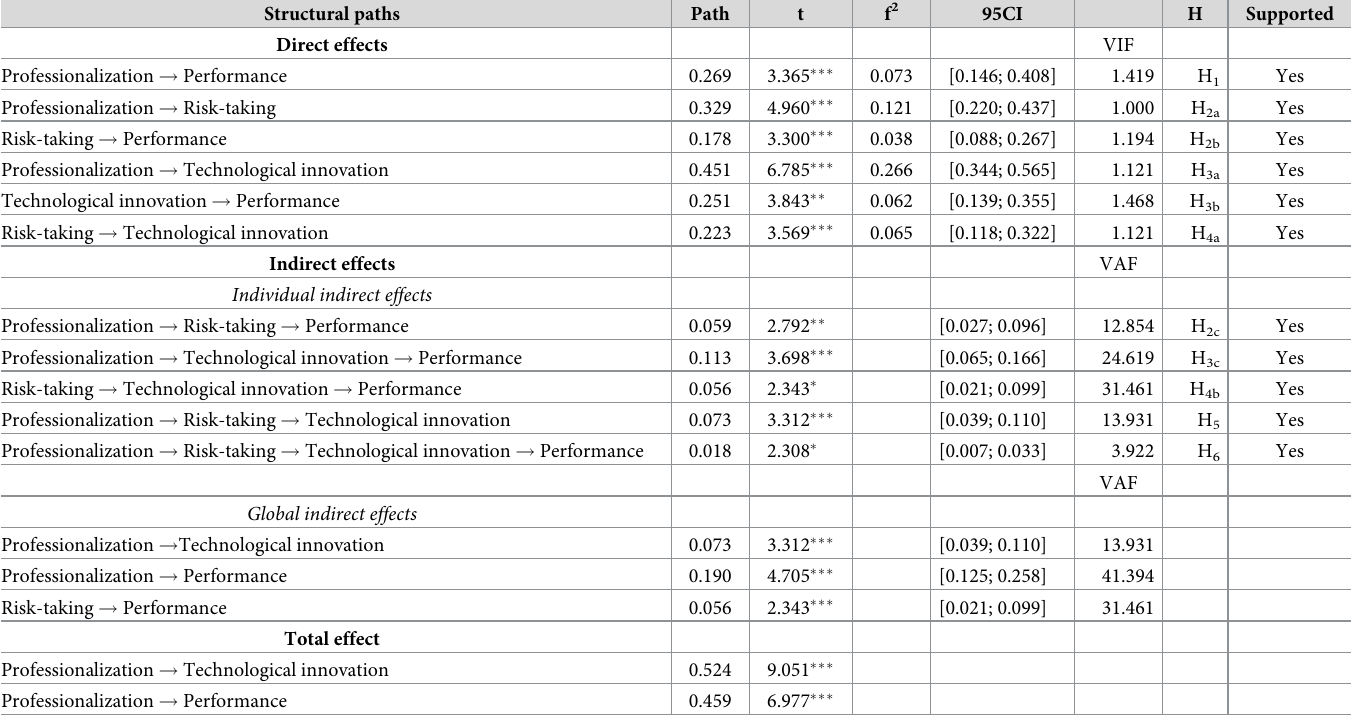
Table 5. Results of the hypothesis testing.